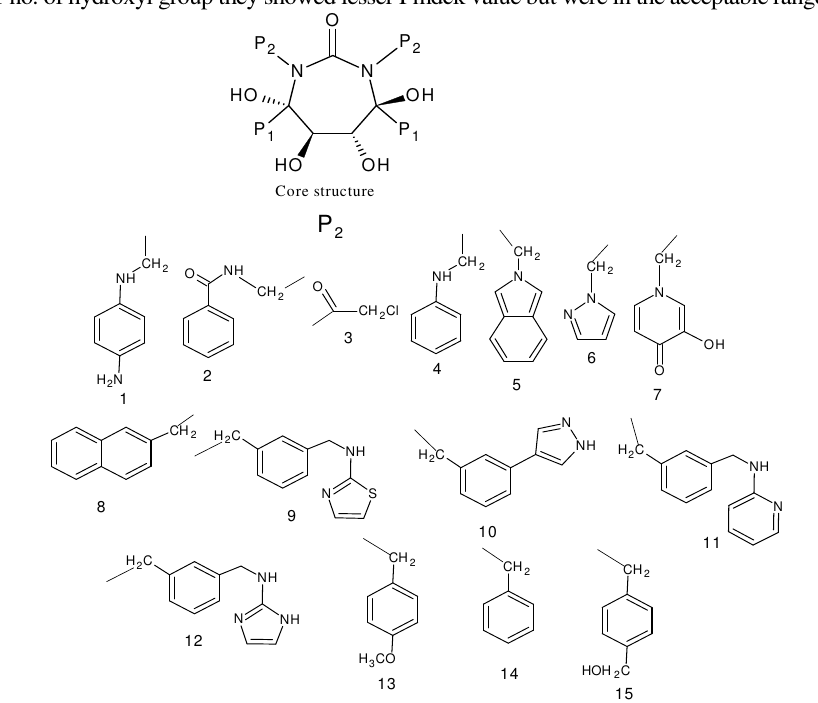
Figure 2. Structures of Terahydroxy molecules Table 3. ADME properties of tetrahydroxy